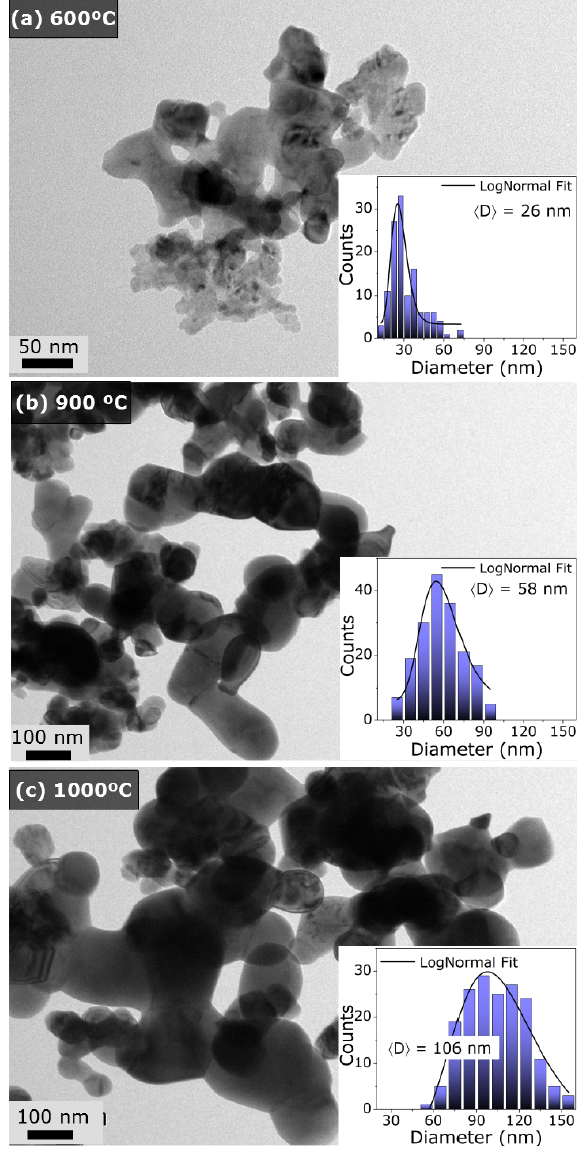
Figure A1. TEM images and particle size distribution for the samples prepared at ( a ) 600 ◦ C (26 nm), ( b ) 900 ◦ C (58 nm), and ( c ) 1000 ◦ C (106